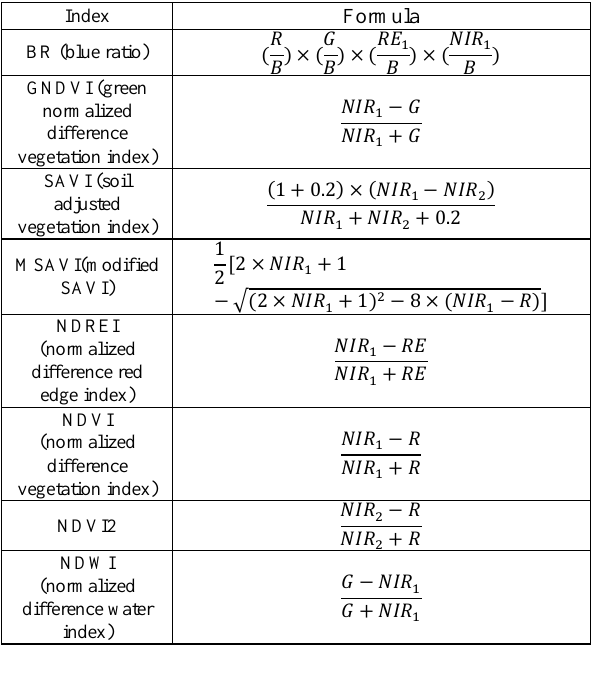
Table 2: Vegetation indexes extracted from Sentinel-2 bands